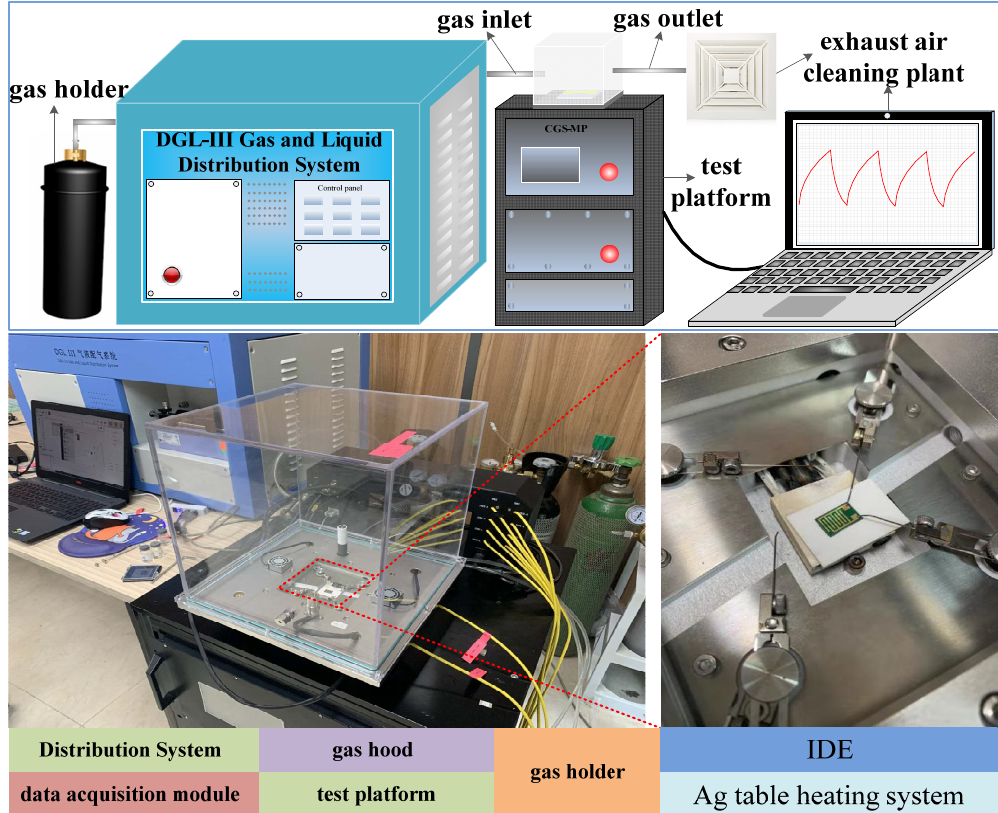
Figure 4. Photoelectric comprehensive test platform (include IDE, Ag table heating system, gas hood, intelligent distribution system, and data acquisition module).